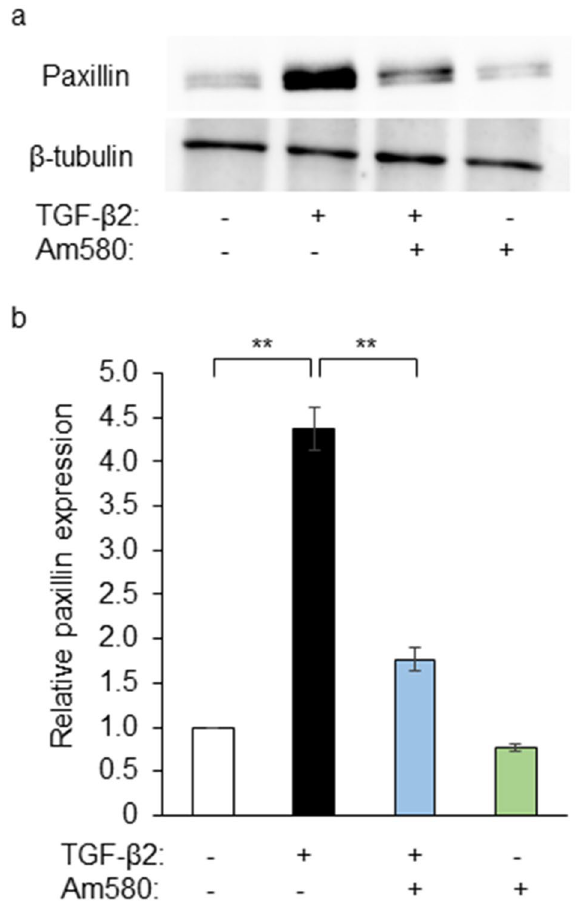
Figure 4. Inhibitory effect of an RAR-α agonist on the TGF-β2-induced expression of paxillin in RPE cells. ( a ) RPE cells were cultured in collagen gels with or without TGF-β2 (1 ng/ml) and Am580 (10 µM) for 48 h, after which cell lysates were prepared and subjected to immunoblot analysis with antibodies to paxillin and to β-tubulin. ( b ) The intensity of each paxillin band in blots similar to that in ( a ) was normalized by that of the corresponding β-tubulin band, and the normalized values were expressed relative to that for control cells and are presented as means ± s.d. for four independent experiments. The intensity of each immunoreactive bands was measured with the use of the Gels commands in ImageJ software. ** P < 0.01 (Dunnett’s